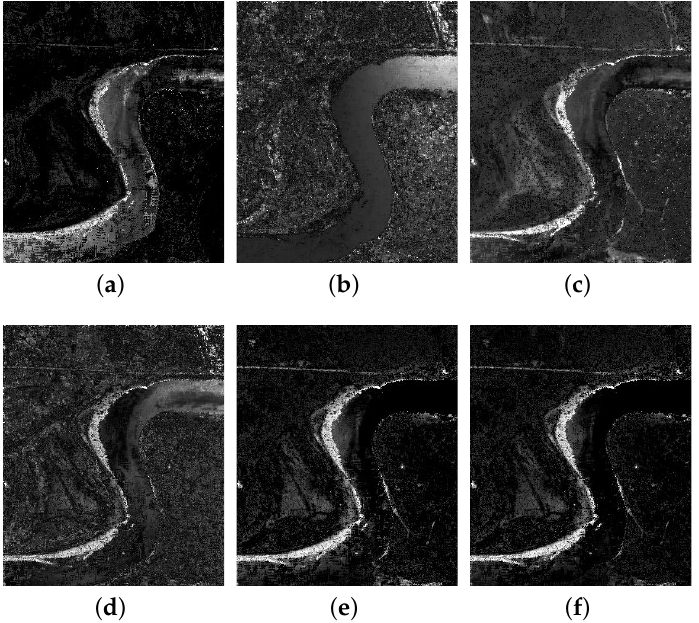
Figure 15. The difference images for the Yellow River dataset obtained according to different numbers of selected pixels. ( a ) Difference image when the number is k /2. ( b ) Difference image when the number is k /4. ( c ) Difference image when the number is k /6. ( d ) Difference image when the number is k /10. ( e ) Difference image when the number is k /13. ( f ) Difference image when the number is k